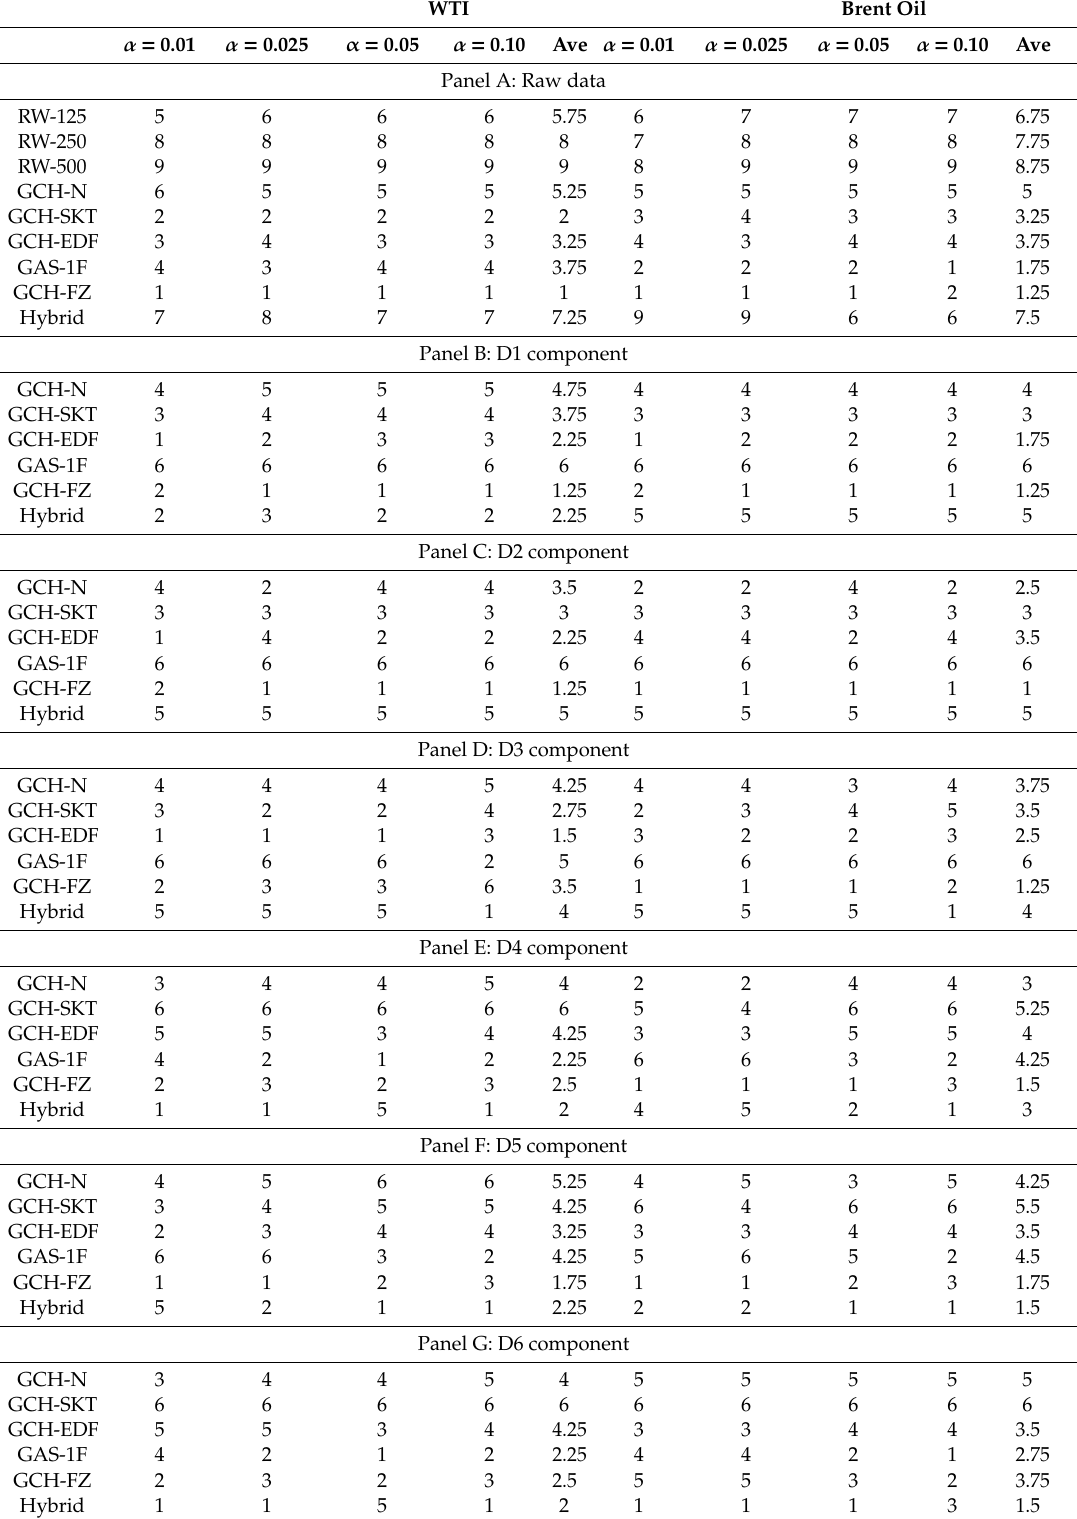
Table 9. The out-of-sample performance rankings for various alpha